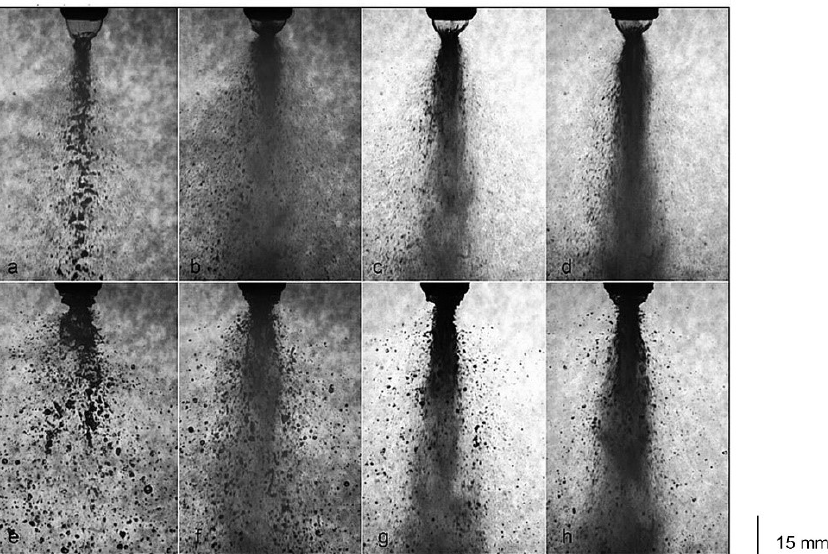
Figure 5. For the converging atomizer with 70 µm ( top row ) and 280 µm ( bottom row ) sheet thickness at a 100 kg/h water flow rate with airflow rates of ( a , e ) 5 kg/h, ( b , f ) 15 kg/h, ( c , g ) 25 kg/h, and ( d , h ) 35 Kg/h, respectively.